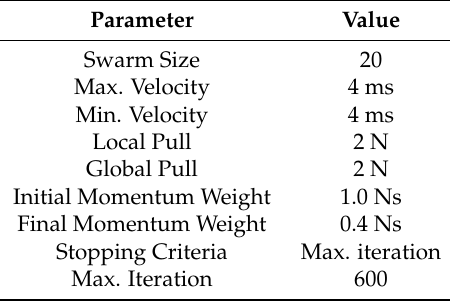
Table 11. BPSO parameters and values.